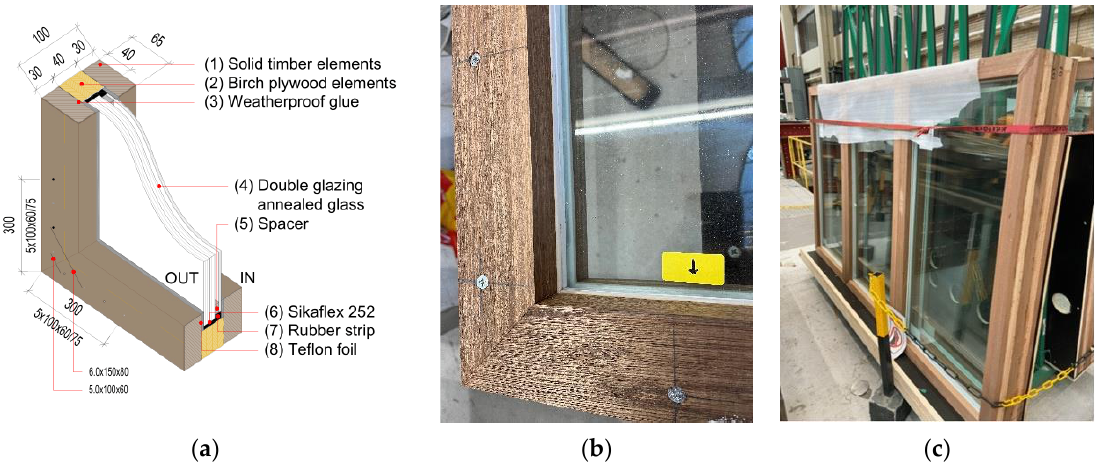
Figure 1. Structural glass window prototype: ( a ) 3D view with components, ( b , c ) final product.